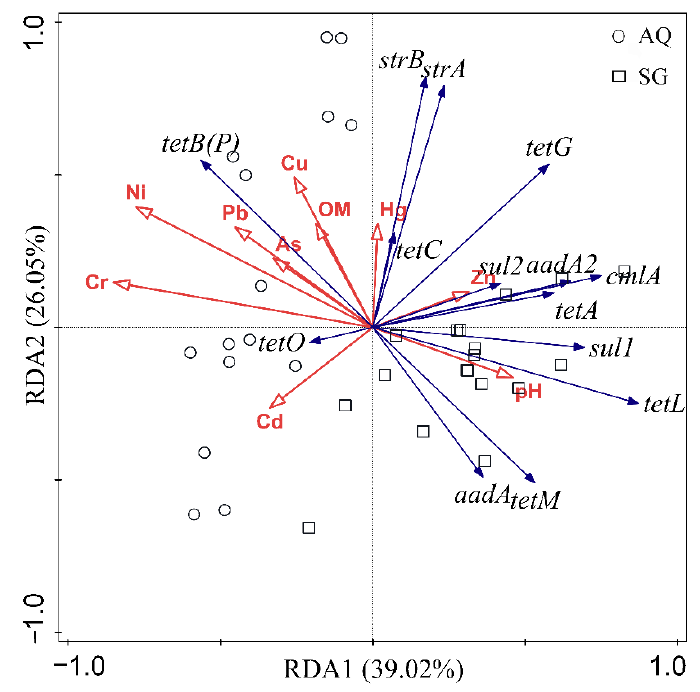
Figure 7. Redundancy analysis (RDA) of ARGs in different greenhouse soils.